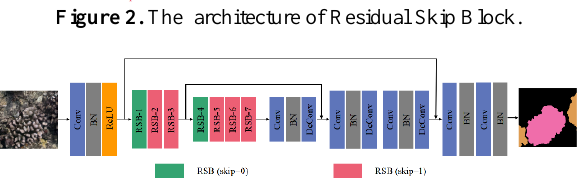
Figure 3. The end-to-end network